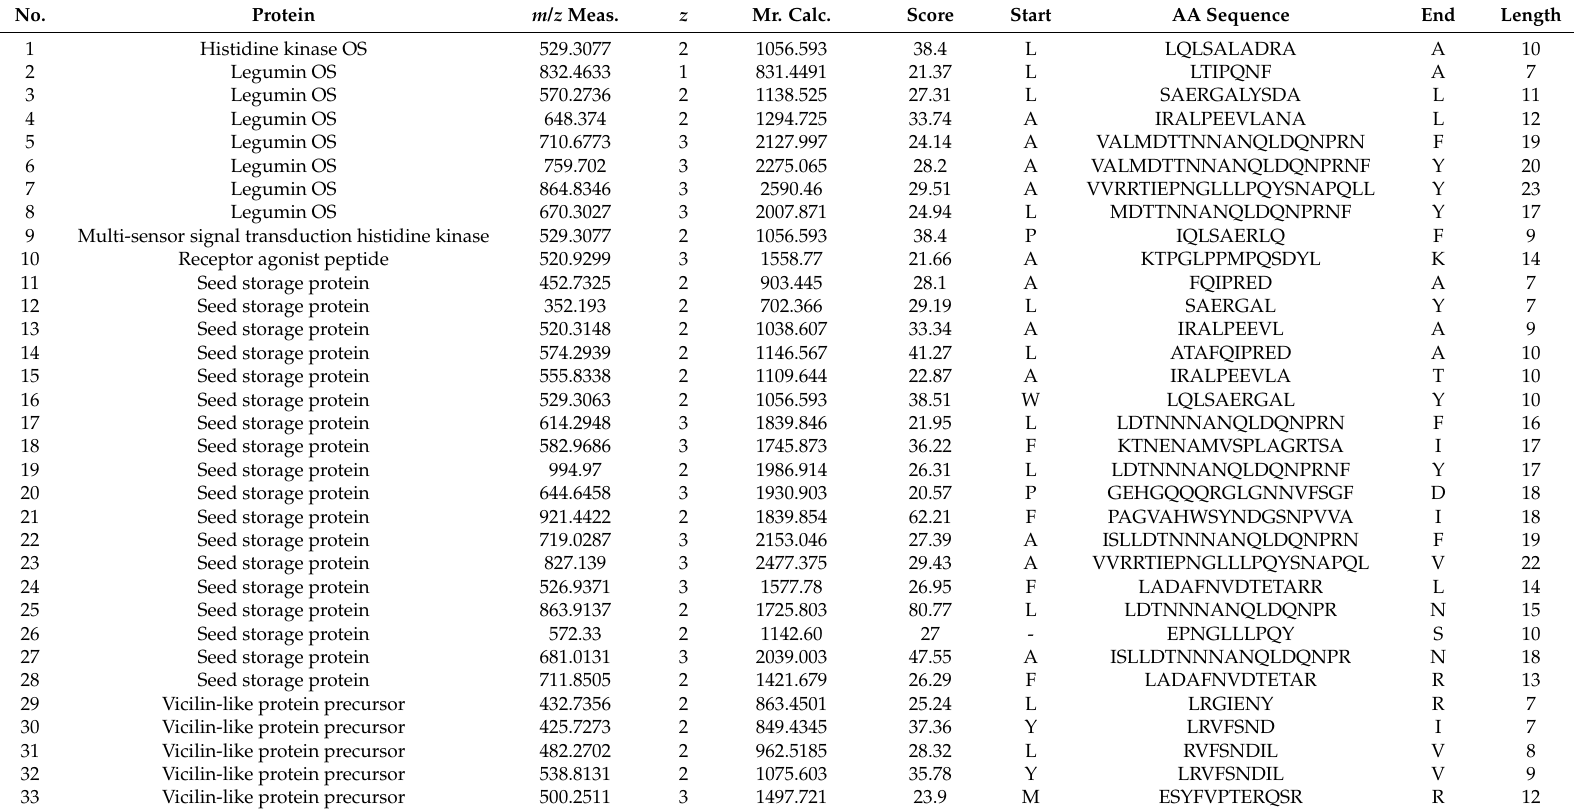
Table 1. Walnut hydrolysate peptides identified by